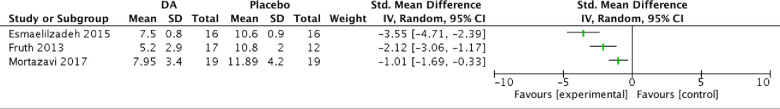
Forest plot of comparison.Aspirin desensitization vs placebo, outcome: Symptom score.